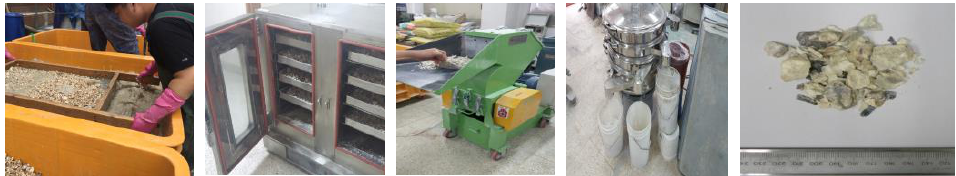
Figure 2. Conversion of oyster shells into OSA (washing, drying, grind in cutter mill, and classification in screen).